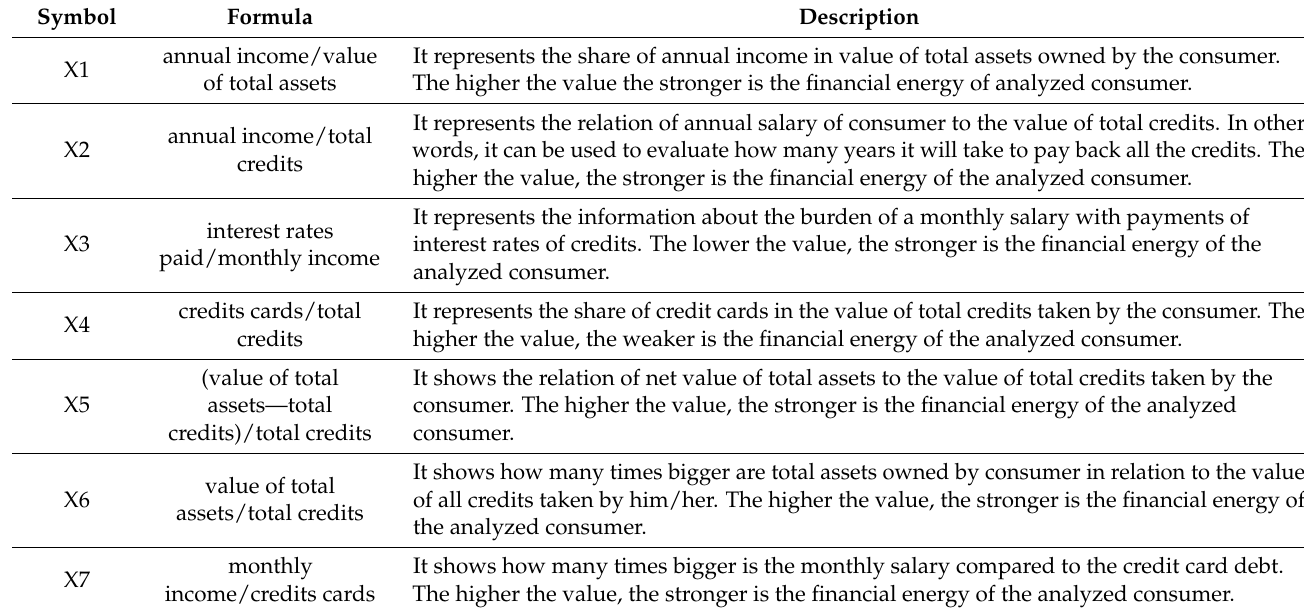
Table 2. The list of created ratios used in evaluating the financial energy of households. Source: based on own studies. Symbol